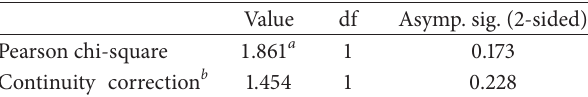
Table 8: Chi-square test of use of ITN or LLITN and use of net and malaria